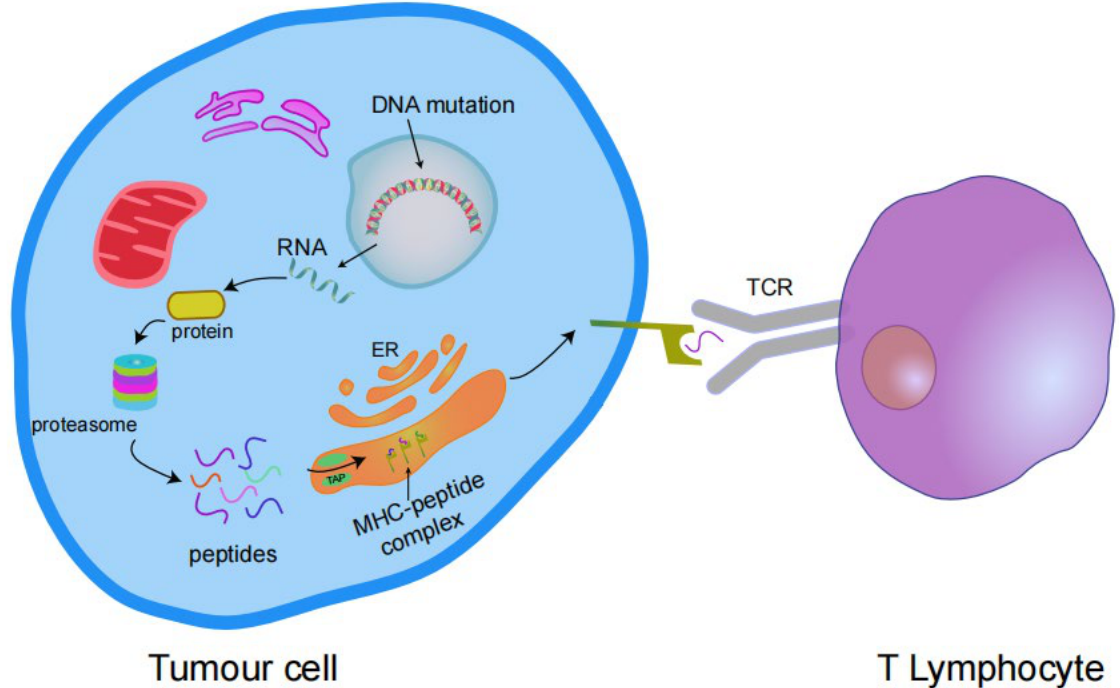
Figure 2. Transcription of mutant genes results in the expression of antigenic proteins that are processed by the proteasome into peptides and enter the endoplasmic reticulum (ER) via transporters associated with antigen processing (TAP) complexes. These peptides bind to the MHC I complex and are expressed on the cell surface and then bind to the T cell receptor (TCR) to activate T cells. Neoantigens are a class of tumour-specific antigens that are different from traditional tumour-associated antigens (TAAs). TAAs are not unique to tumour tissue because they are also present in normal tissue. TAAs are expressed at high levels in proliferating tumour cells; for example, tumour cells express HER2 , MUC1 and MAGE [24]. Currently, most